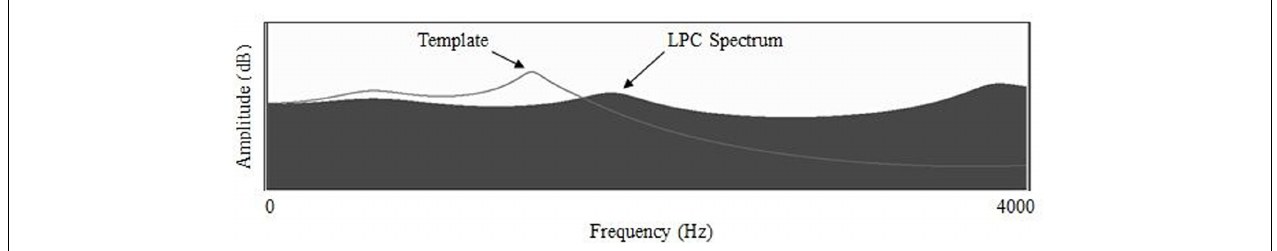
FIGURE 1 | Formant frequencies represented as peaks of an LPC spectral display, with line representing an accurate rhotic target. From McAllister Byun and Hitchcock (2012); used with